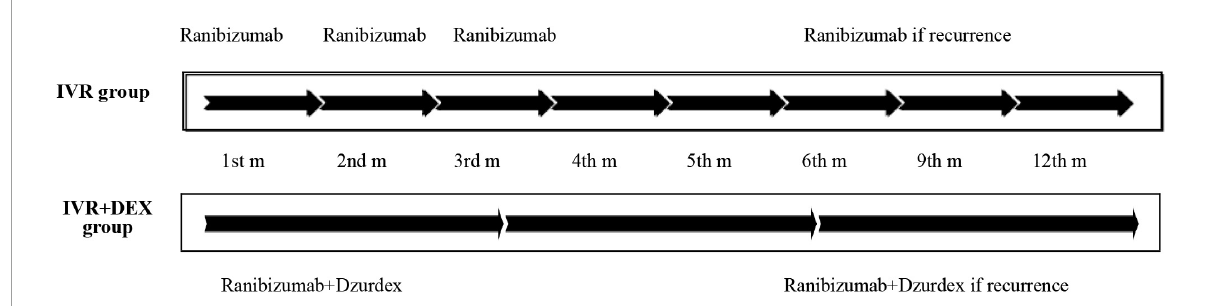
FIGURE1 Treatment strategy (timeline): ranibizumab (IVR) monotherapy vs. ranibizumab plus dexamethasone (IVR + DEX) implant. During the study period, recurrence was treated in both groups at CFT > 300 µ m or presenting subretinal or intraretinal